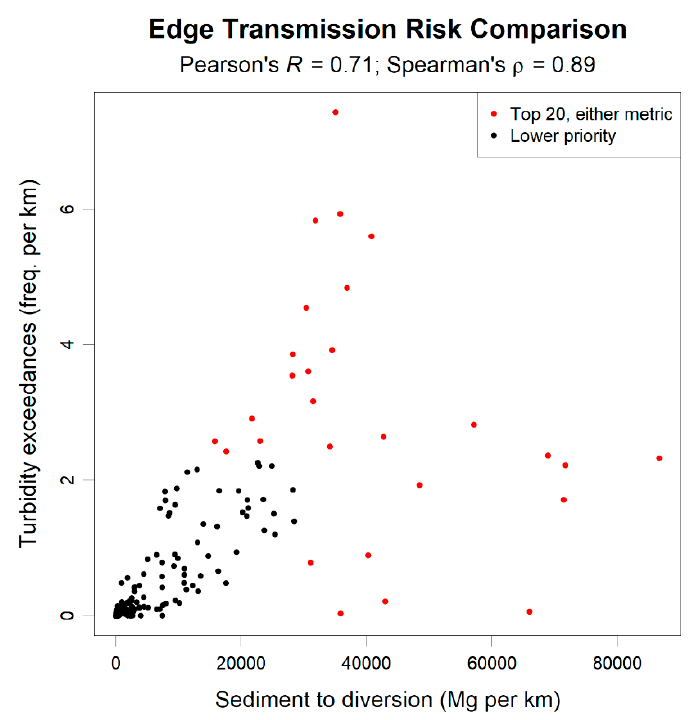
Figure 8. Edge transmission risk comparison for 2-year rainfall erosivity. Edges ranked in the top 20 using either metric are colored red.